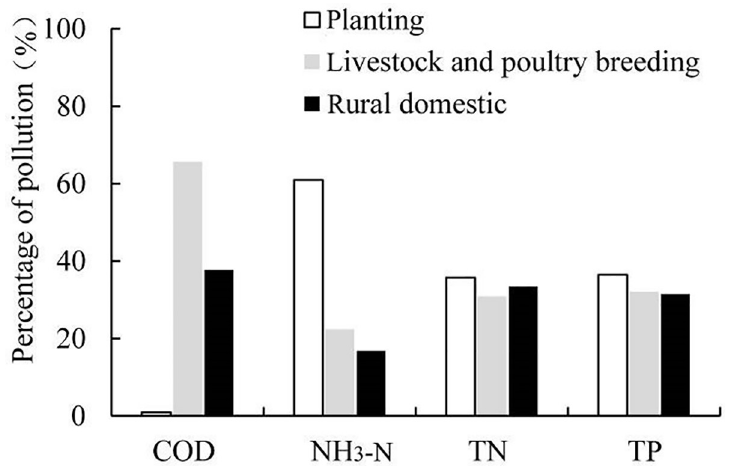
Fig 7. Relative contribution of the pollution into river from different pollution source in Baiyangdian